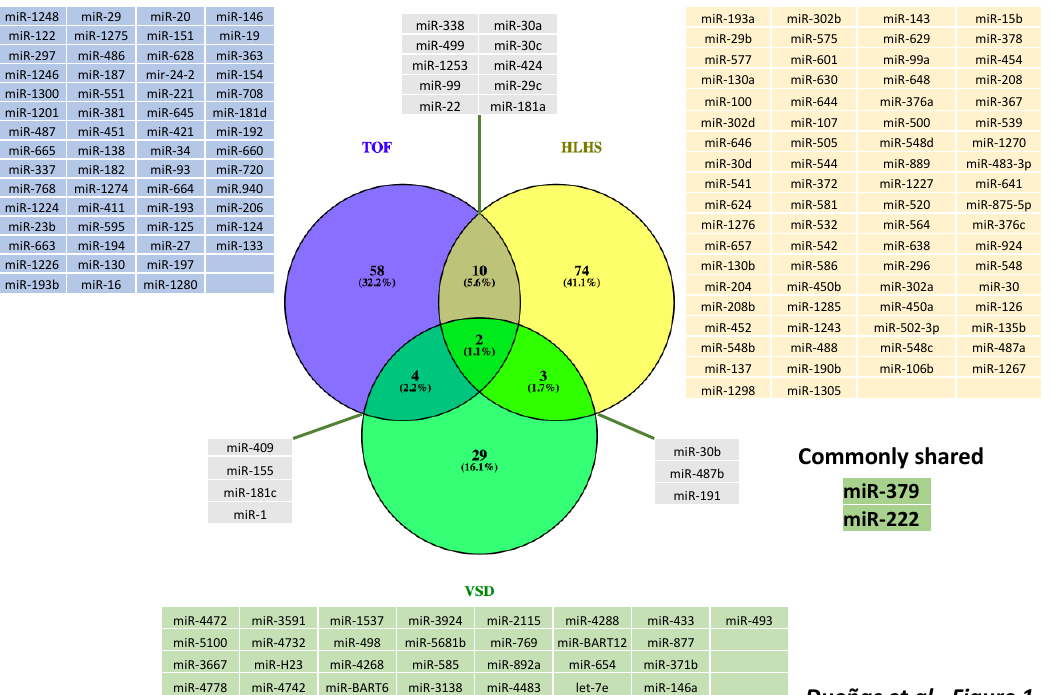
Figure 1. Schematic representation of distinct microRNAs involved in TOF (Tetralogy of Fallot), HLHS (Hypoplastic Left Heart Syndrome) and VSD (Ventricular Septal Defect), as reported by distinct di ff erential gene expression analyses. Observe that the majority of the di ff erentially expressed microRNAs are associated to a single CHD entity and only 1.1% are shared among all three CHDs, i.e., miR-379 and